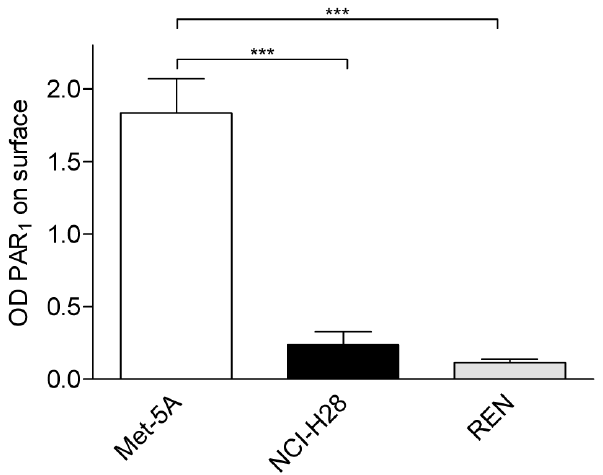
Figure 3. NCI-H28 and REN cells express significant less amount of PAR 1 on plasma membrane. Cell surface PAR 1 expression was measured by ELISA using a polyclonal antibody which recognizes the N-terminus of PAR 1 [31]. Antibody binding to fixed cells was detected by horseradish peroxidise-conjugated secondary anti- body. Data represent the mean 6 SEM of three independent experiments performed in triplicate. The differences in cell surface PAR 1 expression between Ctrl (Met-5A cells) and MPM (NCI-H28 and REN) cellswere significant (***P # 0.001) by one-way ANOVA followed by Bonferroni’s multiple comparison test.